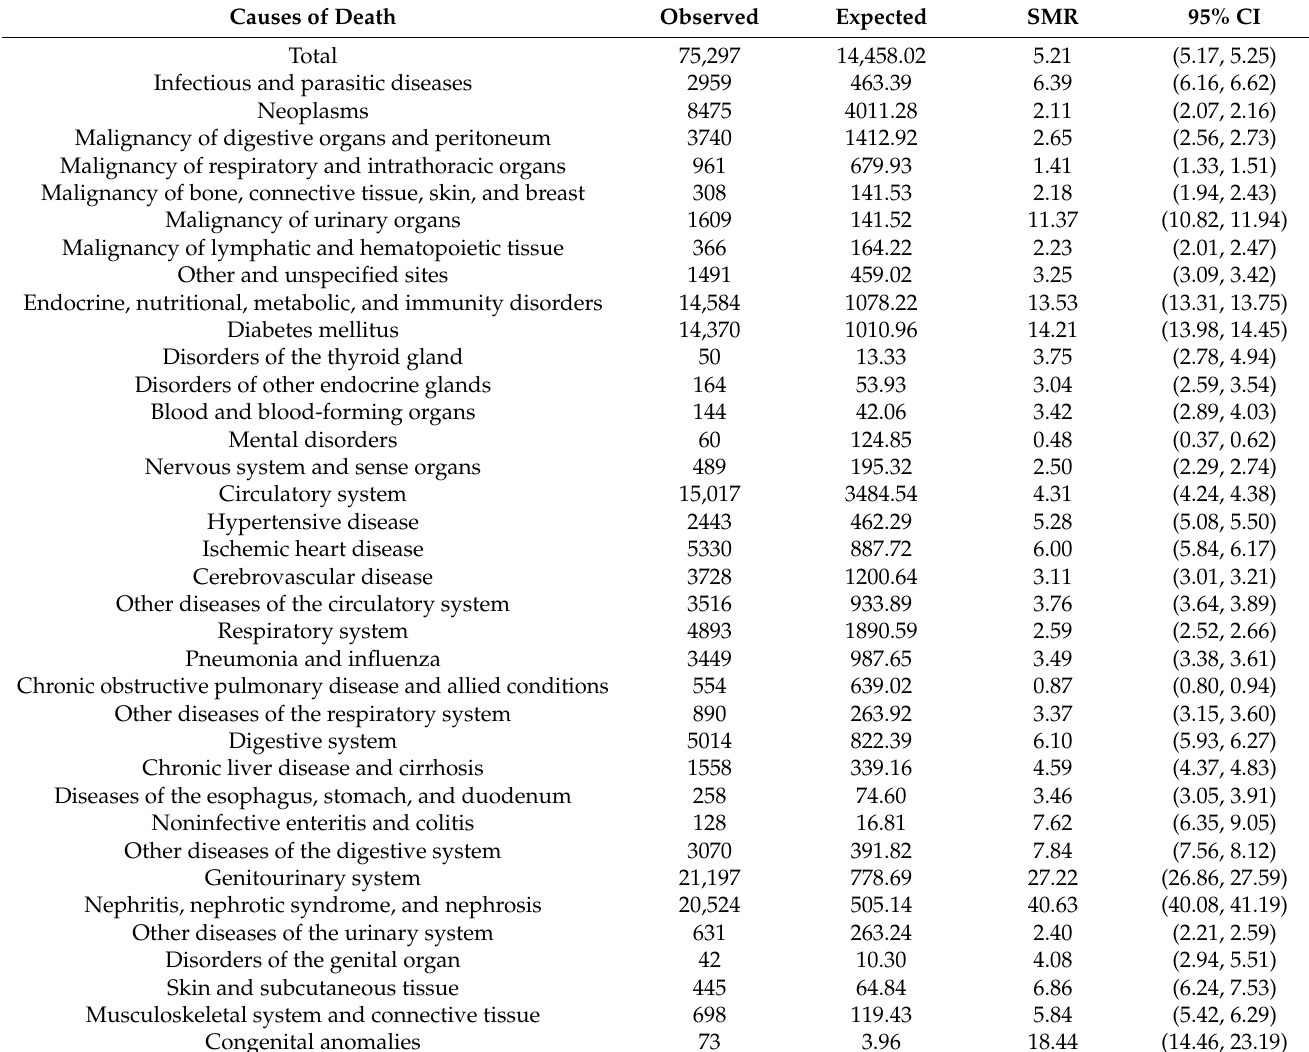
Table 2. All-cause standardized mortality ratio (SMR) of all dialysis